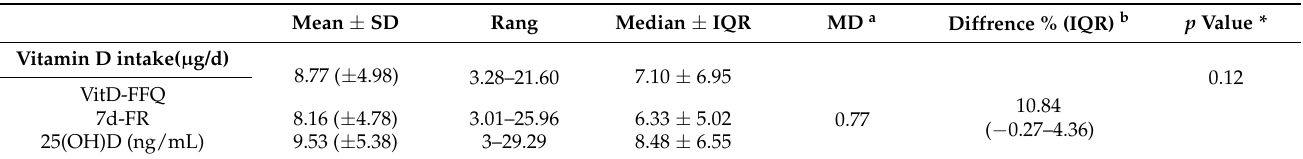
Table 4. Vitamin D daily intake assessed by VitD-FFQ and 7d-FR 7 and 25(OH)D Serum concentration in 152 study participants.